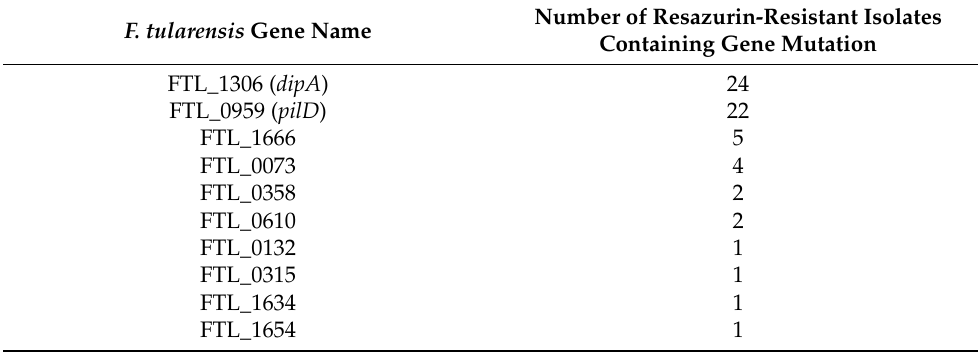
Table 1. Protein-coding genes containing nonsynonymous mutations in 46 resazurin-resistant F. tularensis isolates